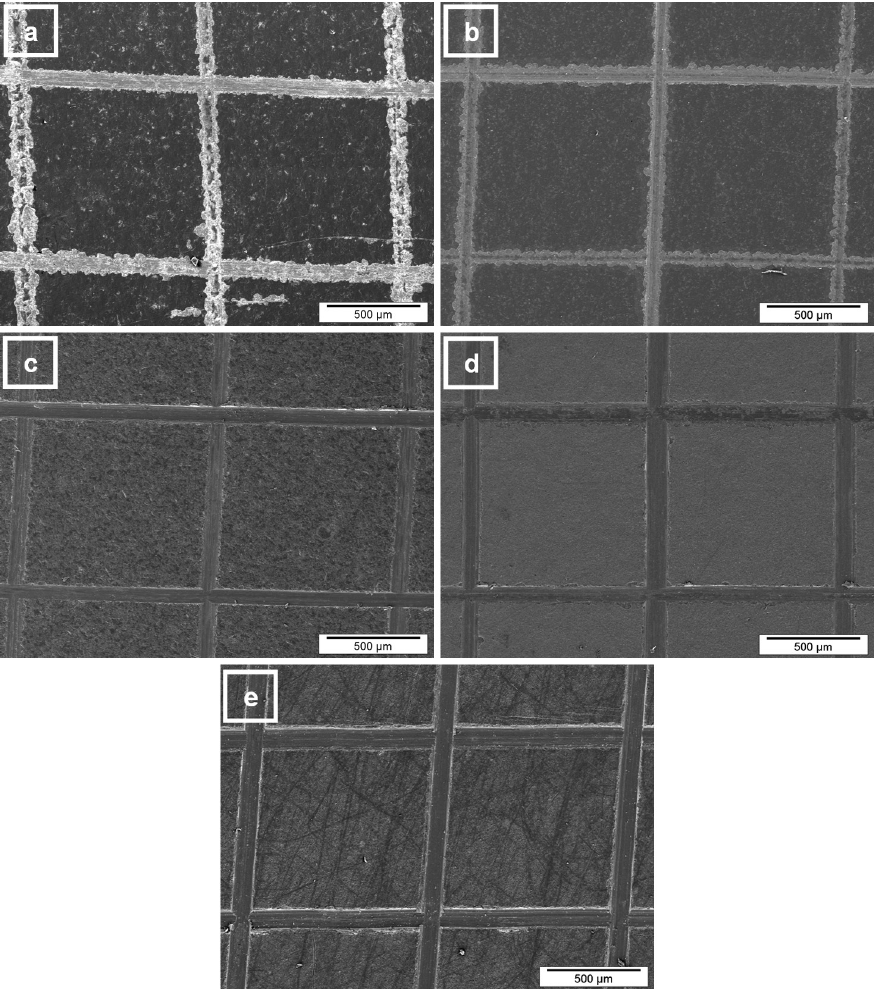
Figure 4. Micrographs of coatings from: (a) pure PMMA; (b) 90%PMMA-10%hBN; (c) 70%PMMA-30%hBN; (d) 50%PMMA-50%hBN; (e) 30%PMMA-70%hBN, on stainless